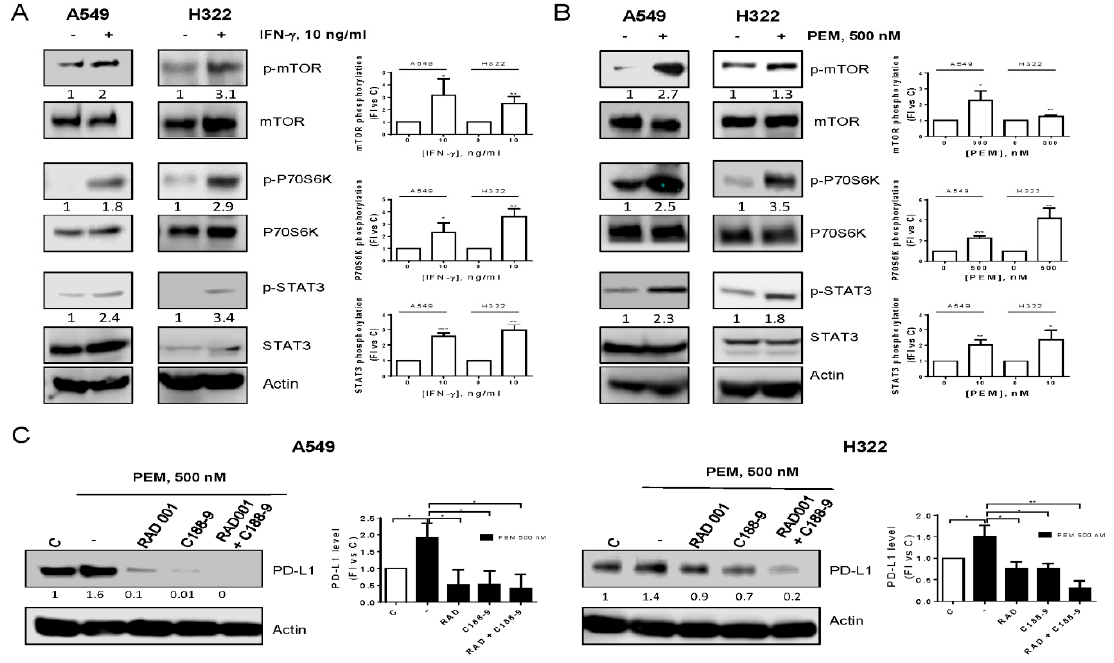
Figure 3. Pemetrexed induced mTOR and STAT3 pathway activation. A549 and H322 cells were treated with 10 ng/mL IFN- γ ( A ) or 500 nM pemetrexed ( B ) for 16 h and cell extracts were analyzed by western blotting with the indicated antibodies. ( C ) A549 and H322 cells were pre-incubated with 100 nM RAD001 or 25 μ M C188-9; after 4 h, 500 nM pemetrexed was added to the cells; and 24 h later, cell extracts were analyzed by western blotting. Data are representative of three independent experiments. * p < 0.05; ** p < 0.01; *** p < 0.001.